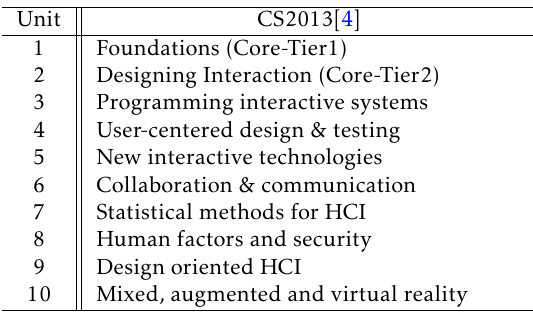
Table 1. HCI course in CS2013